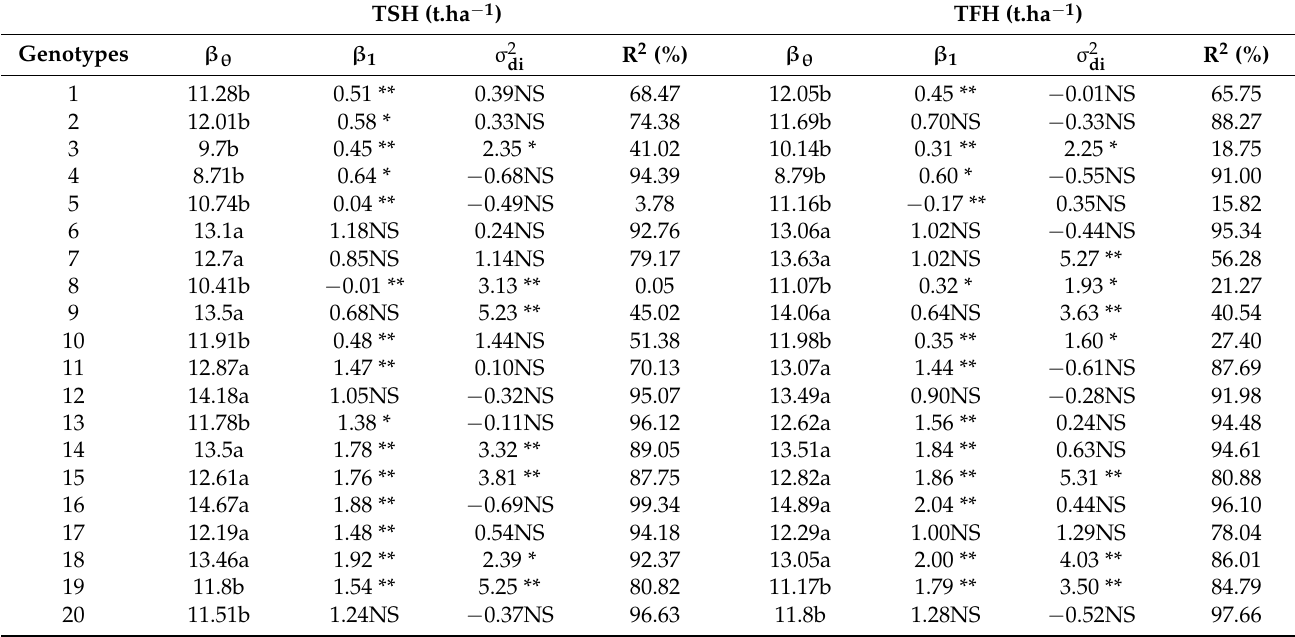
Table 5. Adaptability and Phenotypic Stability of 20 sugarcane genotypes with respect to the traits tons of sucrose per hectare (TSH), and tons of fiber per hectare (TFH), evaluated in experiments conducted in the final stages of experimentation (FE), in the five sugarcane microregions of the State of Pernambuco, considering two harvest